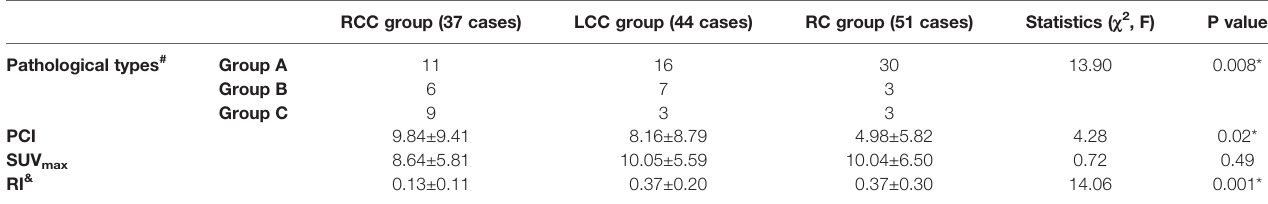
TABLE 2 | Differences in pathological type of CRC, PCI, SUV max and RI of peritoneal carcinomatosis in different locations of